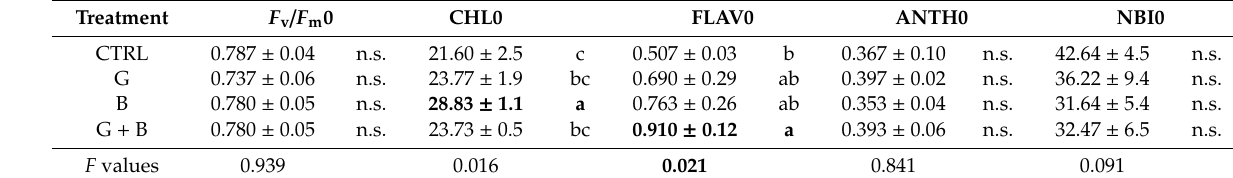
Table 2. Parameters measured before chilling stress in the first and second experiment ( A and B , respectively). ( 1 ) Physiological parameters: F v / F m = photochemical e ffi ciency of photosystem II (PSII), CHL = index of the chlorophyll content in leaf measured using a DUALX instrument, FLAV = index of the flavonoid content in leaf measured using a DUALX instrument, ANTH = index of the anthocyanin content in leaf measured using a DUALX instrument, NBI = nitrogen balance index. ( 2 ) Morphological non-destructive parameters: H = height of seedlings, D = stem diameter of seedlings, H / D = height to diameter ratio, LN (no.) = number of leaves per seedling, LA = leaf area, SLM = specific leaf mass. ( 3 ) Morphological destructive parameters: LDW = leaf dry weight, SDW = stem dry weight, RDW = root dry weight, TDW = total dry weight, FTL = fraction of total dry weight to leaves, FTR = fraction of total dray weight to roots. 0 = measured or recorded before stress, CTRL = seedlings without microorganism treatment, G = seedlings inoculated with Funneliformis mosseae , B = seedlings inoculated with Paraburkholderia graminis , G + B = seedlings inoculated with Funneliformis mosseae + Paraburkholderia graminis , TREAT = treatment, GENO = genotype. Data are presented as mean ± standard deviation (SD) (in the first experiment n = 5; in the second experiments n treatment = 15 and n genotype = 20). Di ff erent letters indicate statistically significant di ff erences among treatments or genotypes by ANOVA followed by Duncan’s test at p < 0.05, n.s. = not significant, ** = p < 0.01, * = p < 0.05. Bold fonts indicate higher